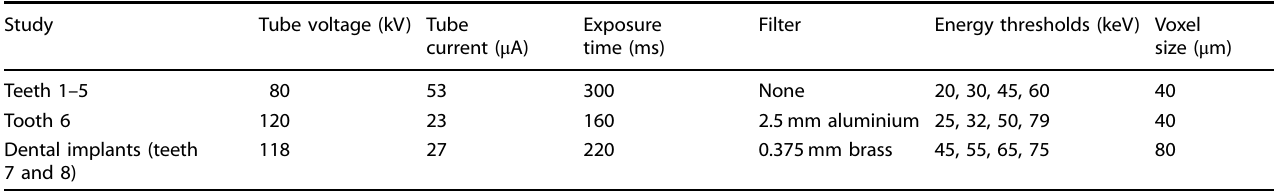
Table 1. Scanning parameters used for the MARS PCSCT